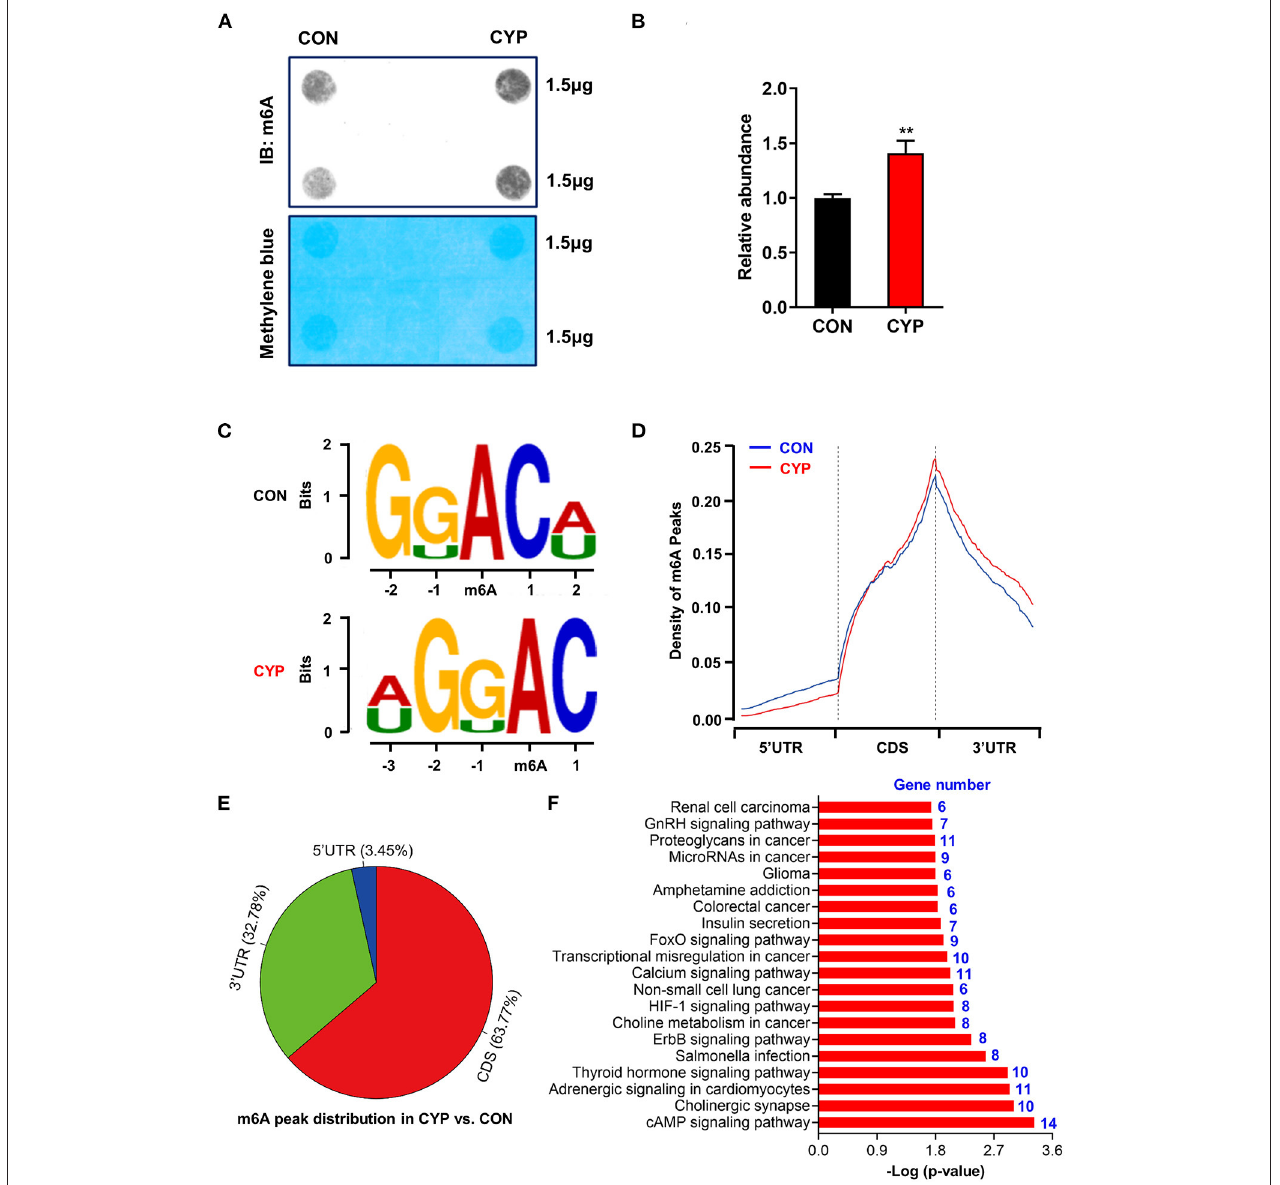
FIGURE 4 | Overview of altered m6A-tagged transcripts landscape in NRCMs with or without CYP. (A) The m6A dot blot assay was conducted in NRCMs after treatment with CYP or solvent control (CON) for 2 days. Methylene blue staining was used as the loading control. (B) Quantitative analysis of m6A abundance in NRCMs treated with CYP or CON for 2 days. (C) Top sequence motif identified from MeRIP-seq peaks in control and CYP-treated NRCMs. (D) Metagene plots showing the region of average m6A peaks identified across all transcripts in NRCMs with solvent control or CYP. (E) Pie charts showing m6A peak distribution in DEGs between CYP and control (CON) groups. (F) The top twenty significantly enriched pathways of upregulation of m6A peaks transcripts. The data are shown as the mean ± SE from three separate experiments. * P < 0.05; ** P < 0.01; *** P < 0.001 vs.